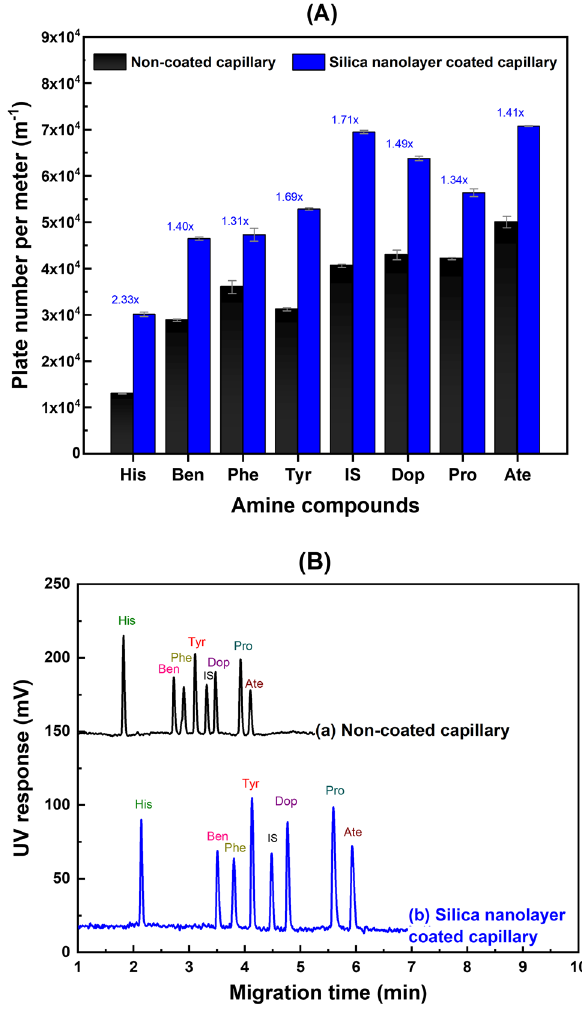
Figure 4. ( A ) Comparisons of plate number per meter for separation of eight amine compounds: histamine (His), benzylamine (Ben), phenylethylamine (Phe), tyramine (Tyr), benzhydrylamine (IS, internal standard), dopamine (Dop), propranolol (Pro) and atenolol (Ate). The numbers above the bar plots for silica nanolayer coated capillary are the fold-increase over the non-coated capillary. ( B ) Electropherograms of eight standard amines separation using (a) non-coated capillary and (b) silica nanolayer coated capillary. The concentrations are: His (400 μg L -1 ), Ben (200 μg L -1 ), Phe (100 μg L -1 ), Tyr (200 μg L -1 ), Dop (100 μg L -1 ), Pro (1000 μg L -1 ), Ate (500 μg L -1 ) and IS (100 μg L -1 ). The CEC conditions are: running buffer: 20.0 mM phosphate buffer (pH 2.5); electrokinetic injection: 400 V cm -1 for 3 s; field strength: 400 V cm -1 ; UV detection: 200